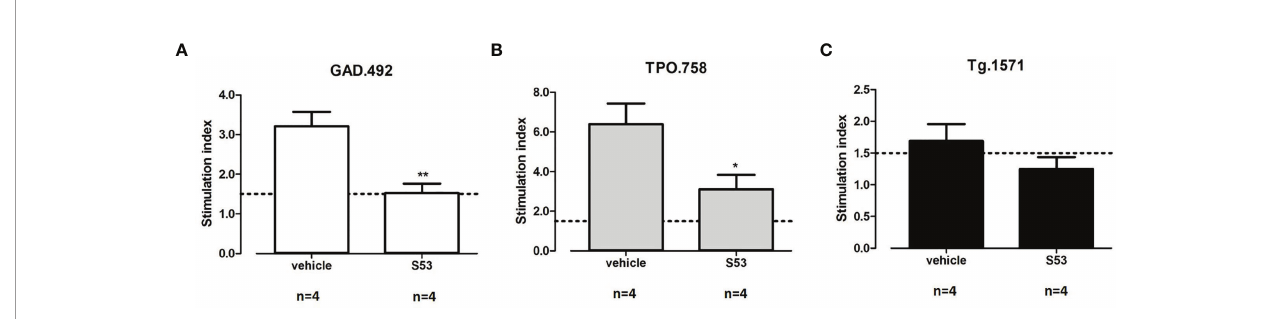
FIGURE 9 | Four humanized NOD-DR3 mice were co-immunized with Tg.1571, GAD.492 and TPO.758 and treated with Cepharanthine (S53) or vehicle. Stimulated splenocytes were collected and T-cell proliferation assay was performed. Figure 9 shows the stimulation index in response to GAD.492 (A) , TPO.758 (B) and Tg.1571 (C) . *p < 0.05; **p